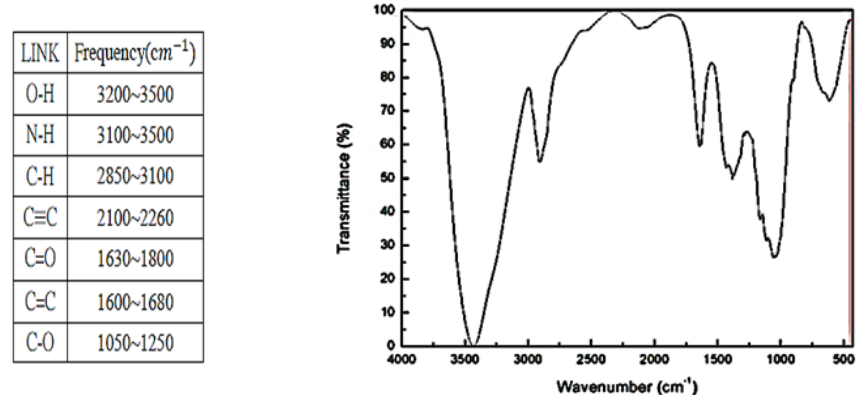
Figure 2. Fourier transform infrared spectroscopy (FTIR) analysis of polyethylene.